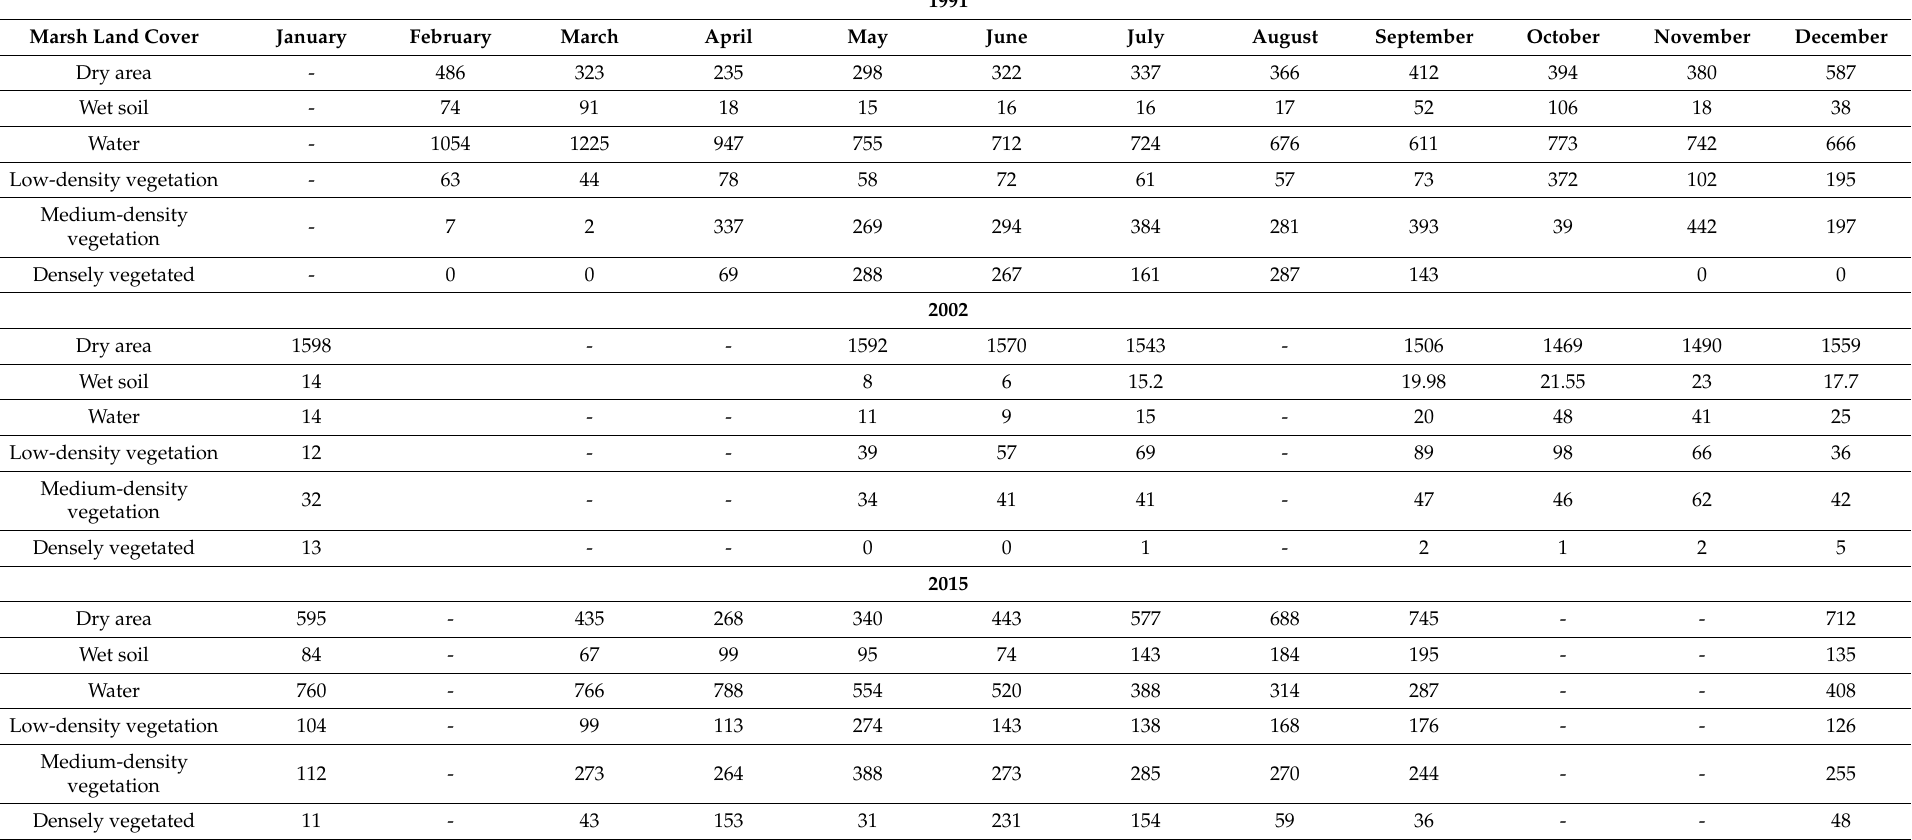
Table A2. Monthly land cover classification area for each class (in km 2 ) for the years 1991, 2002, 2015, 2016, 2017, and 2018.